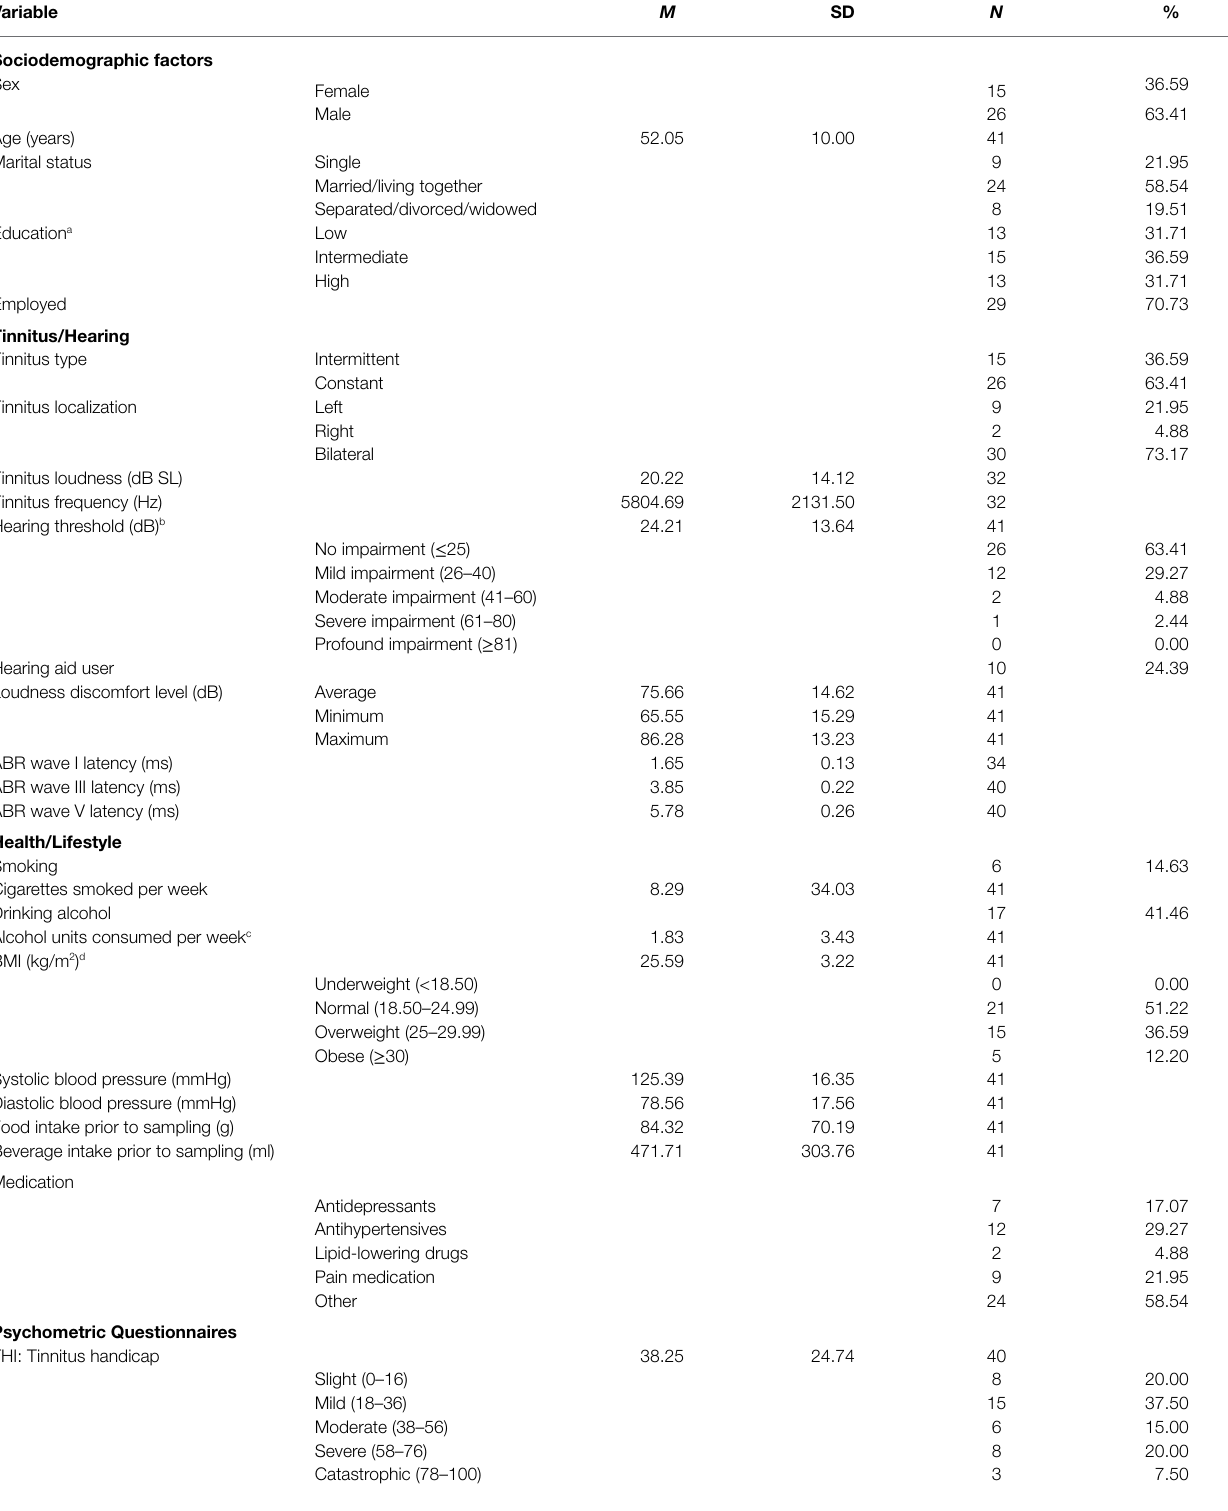
TABLE 1 | Sample description including sociodemographic factors, tinnitus − /hearing-related factors, health − /lifestyle-related factors, and psychometric questionnaires ( N = 41). Variable M